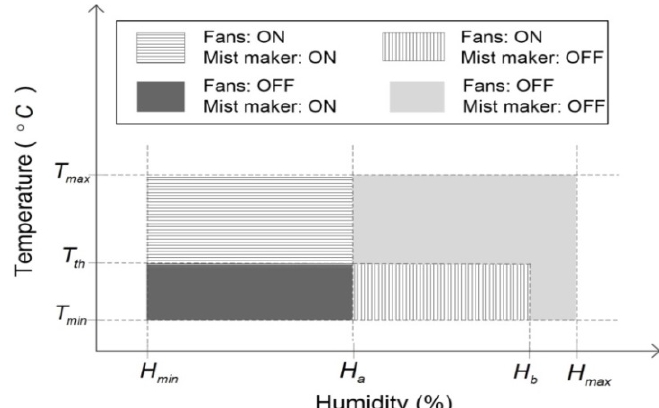
Figure 7. Rules for turning on and off facilities. The thin horizontal lines indicate that the mist generator and fan are turned on when the temperature is too high and the humidity is too low; the dark grey area indicates that only the mist generator is turned on when the humidity is too low; and in the grey area, the mist generator and fan are turned off. A thin vertical line indicates that the humidity is too high and that the fan is turned on to avoid condensation on the